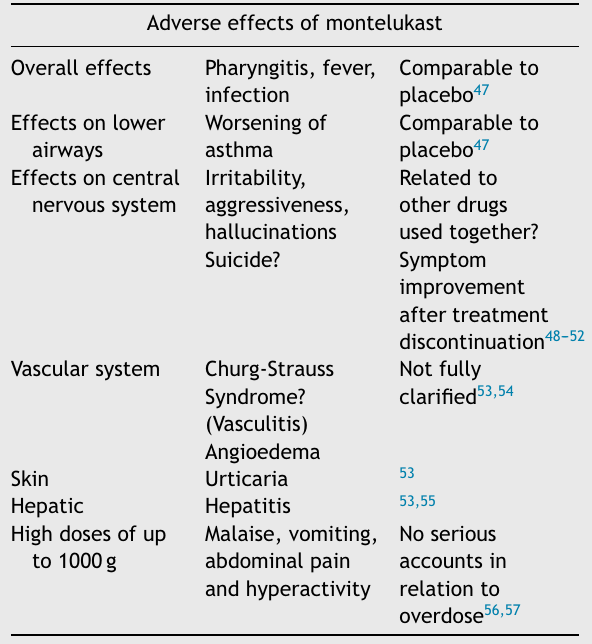
Side effects of antileukotrienes. 48---59 Adverse effects of